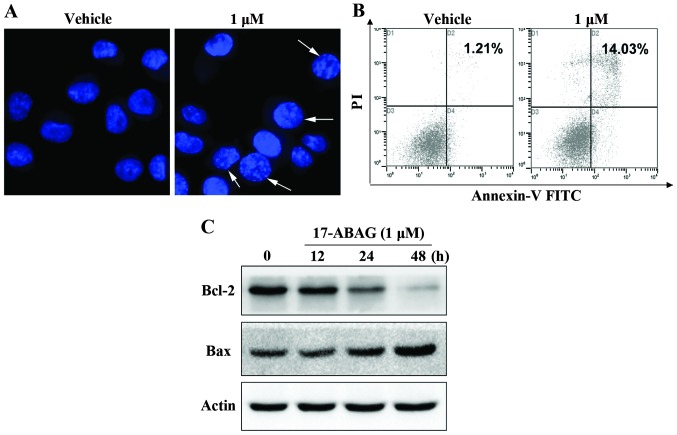
17-ABAG induces prostate cancer cell apoptosis. (A) LNCaP cells were treated for 24 h with or without 1 μM 17-ABAG. The images were captured using fluorescence microscopy (magnification, ×600) to observe nuclear staining with DAPI. Apoptotic cells with condensed nuclei were identified using nuclear staining as indicated by the white arrows. (B) Detection of apoptosis using Annexin V-FITC/PI double staining. After treatment with or without 1 μM 17-ABAG for 24 h, LNCaP cells were analyzed using a FACSCalibur flow cytometer. The horizontal axis represents Annexin V intensity, and the vertical axis shows PI staining. The lines divide each plot into four quadrants: Lower left quadrant, live cells; lower right quadrant, early apoptotic cells; upper left quadrant, necrotic cells; upper right quadrant, late apoptotic cells. (C) Western blot analysis of apoptosis-associated proteins after treatment with 17-ABAG. DU-145 cells were treated for the indicated times with 1 μM 17-ABAG. The DU-145 cells were treated for the indicated periods of time with 1 μM 17-ABAG. The expression levels of Bcl-2 and Bax were determined by western blot analysis. β-actin was used for normalization and verification of protein loading. PI, propidium iodide; Bcl-2, B-cell lymphoma 2; Bax, Bcl-2-associated X protein; FITC, fluorescein isothiocyanate.